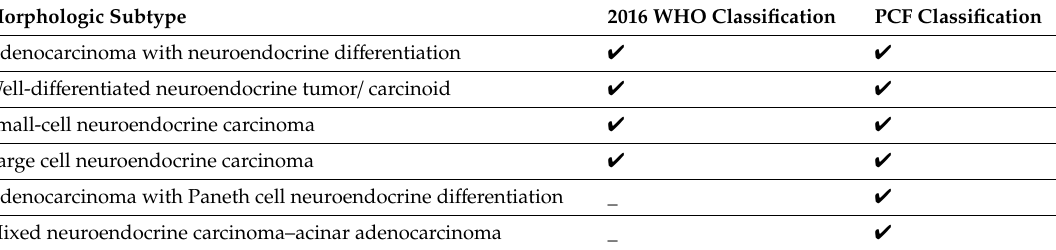
Table 1. Classifications of prostate cancer with neuroendocrine (NE) di ff erentiation. Morphologic